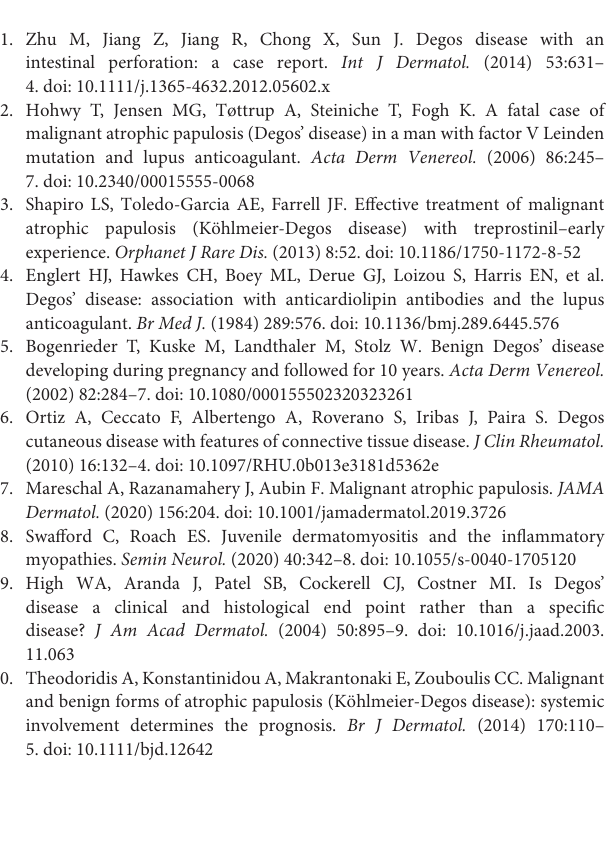
Supplementary Figure 1 | A timeline of patient evaluation and